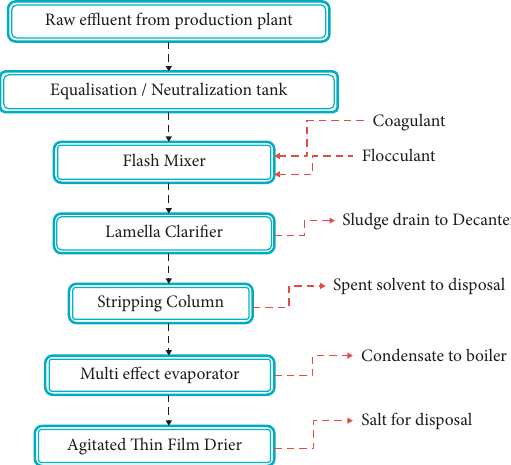
Figure 3: Novel treatment process.